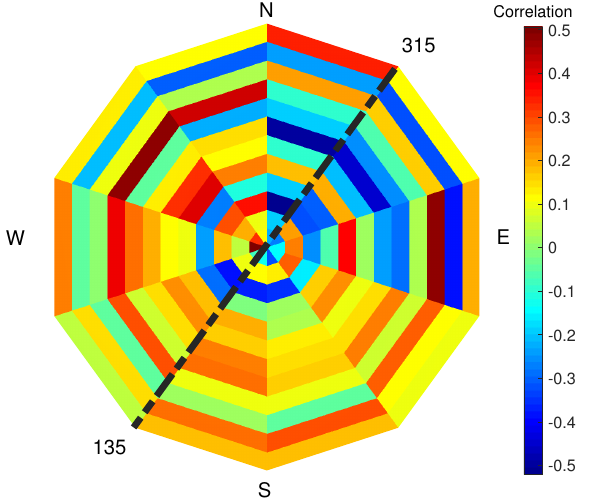
Figure 14. Correlation factor (colour bar) between RMSH and wind speed evaluated for different overlapping sectors ranging in 90° wind directions. In the figure, each sector represents a 90° wind- direction section and each of the 12 rings represent a row of pixels starting from pixel 1, which is located on the sea-side (inner ring), and moving towards pixel 12 (external ring), which is located on the city-side of the study area. The dotted black line represents the orientation of the shore line in